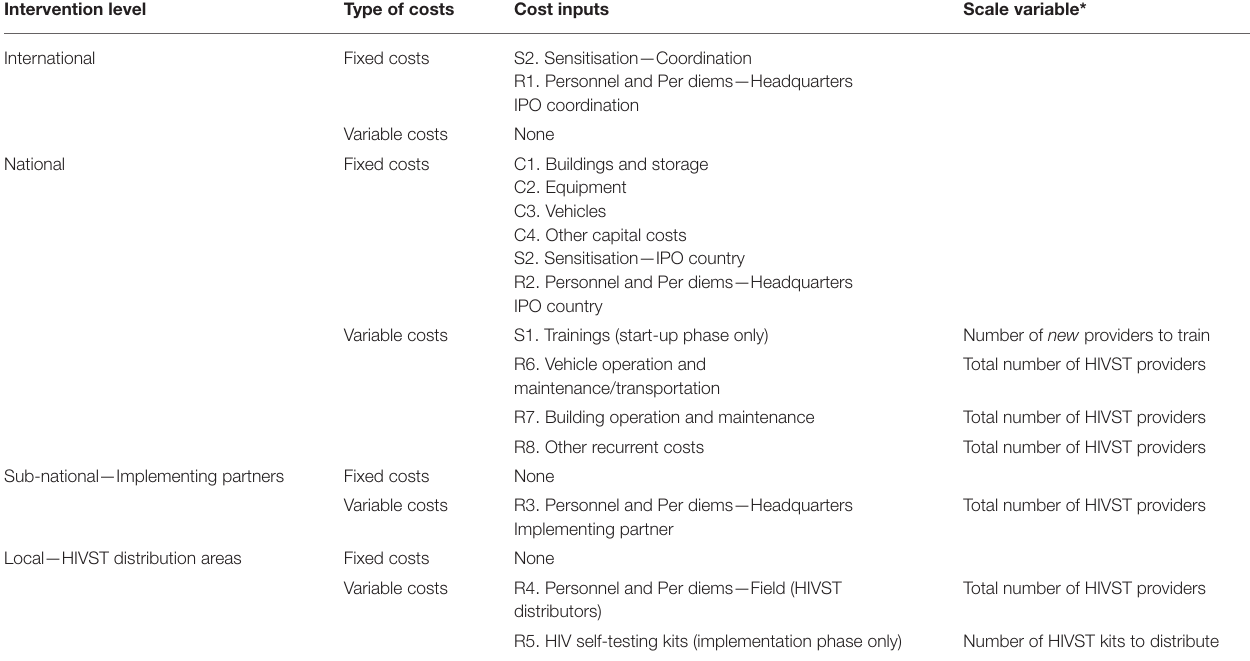
TABLE 2 | Model structure—Accounting cost